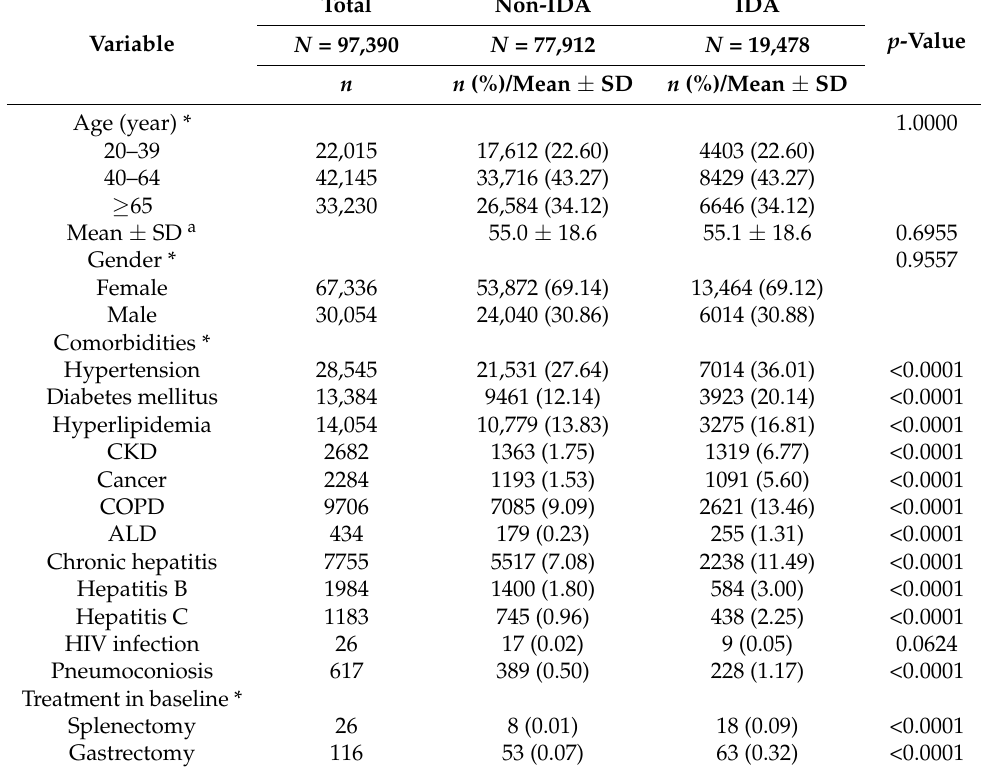
Table 1. Demographic characteristics and comorbidities of subjects with and without iron-deficiency anemia